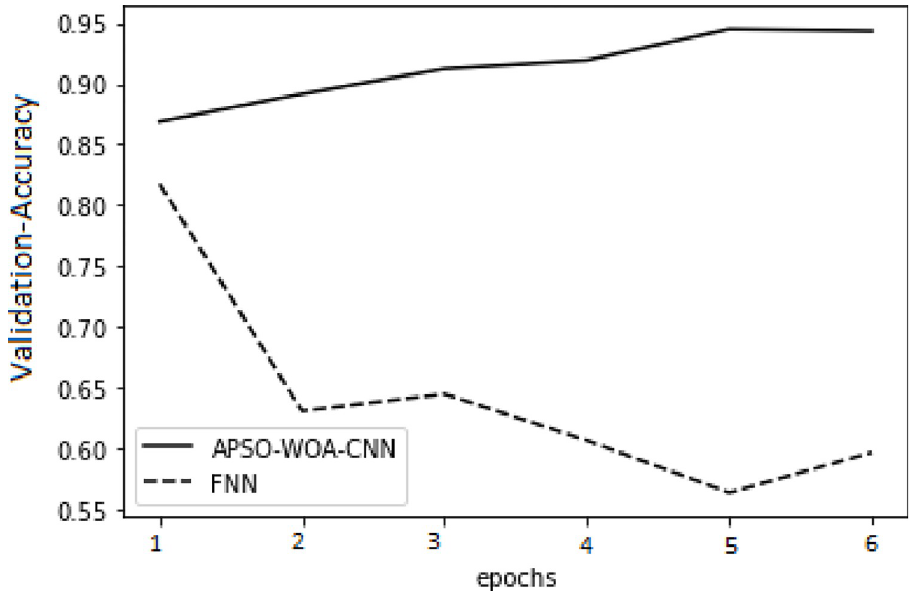
Fig 9. APSO–WOA–CNN and FNN algorithms’ accuracy validation